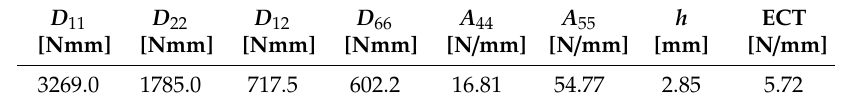
Table 2. Mechanical properties (sti ff nesses, thickness and ECT value) of 3B400 cardboard quality.